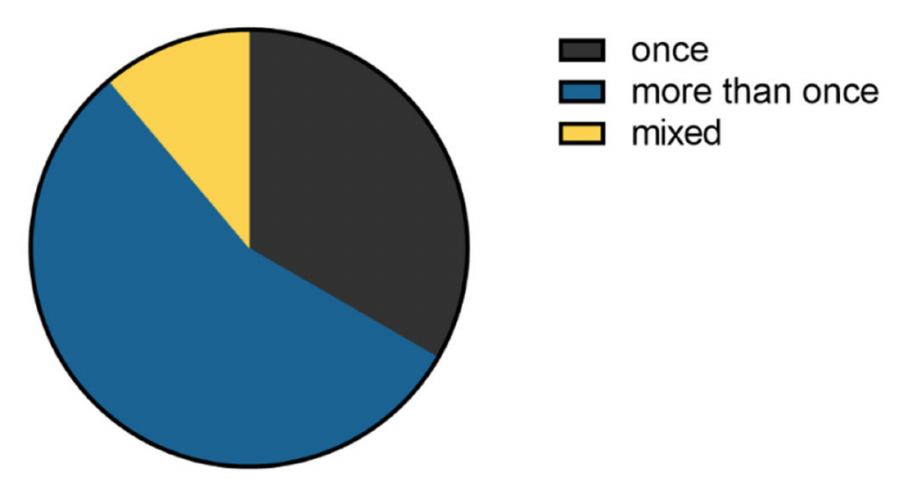
Figure 3. Number of ABR recording sessions per experimental animal as reported in the survey. More than half of the 18 research groups reported using the same animal more than once for the ABR